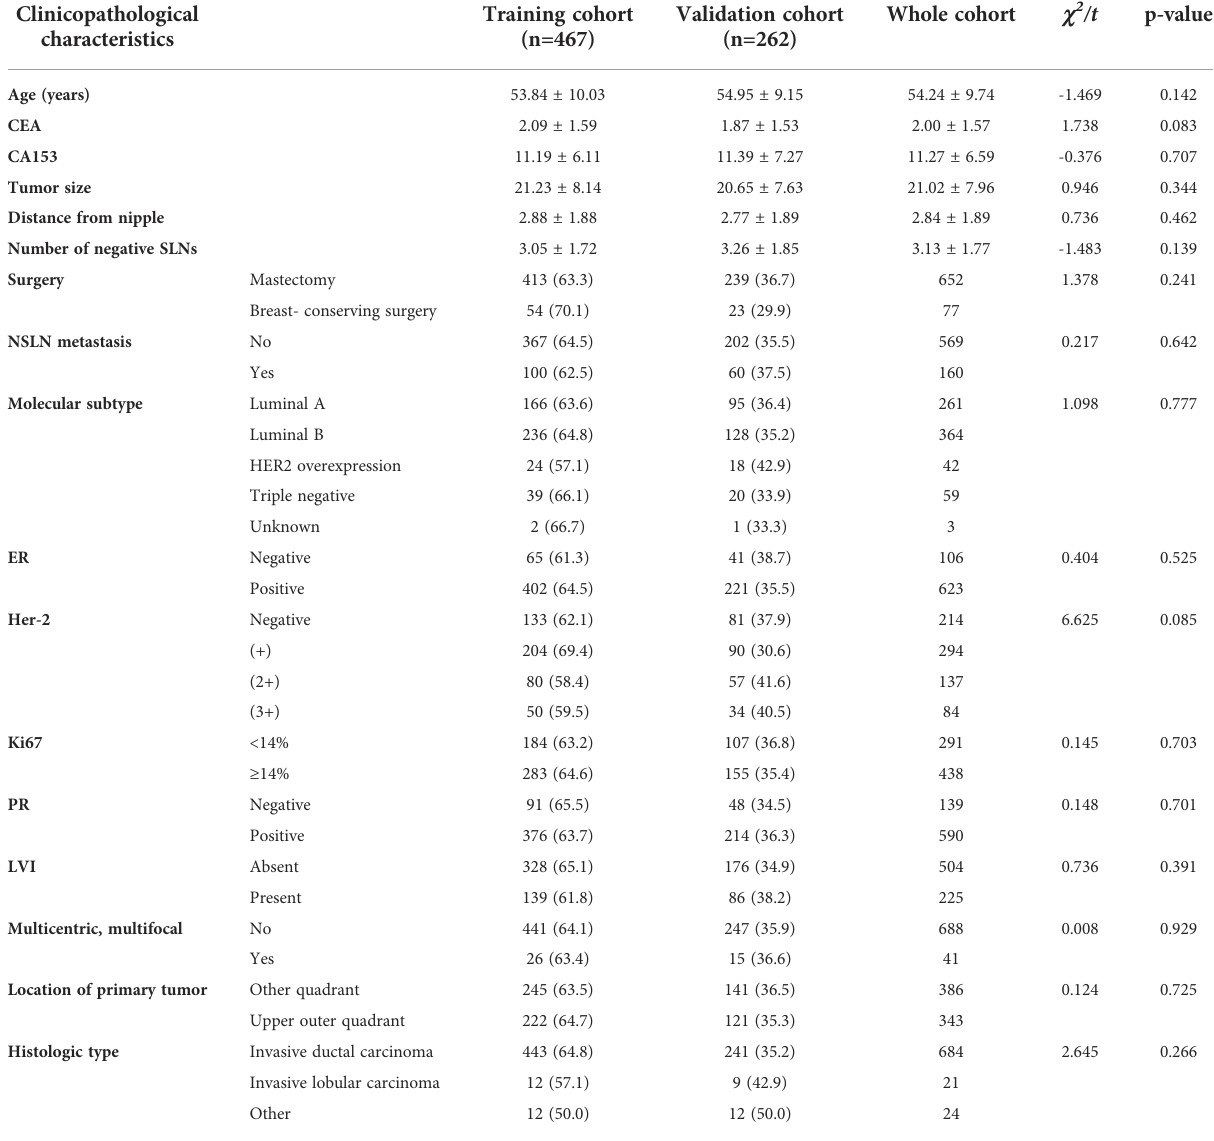
TABLE 1 Clinicopathological characteristics of